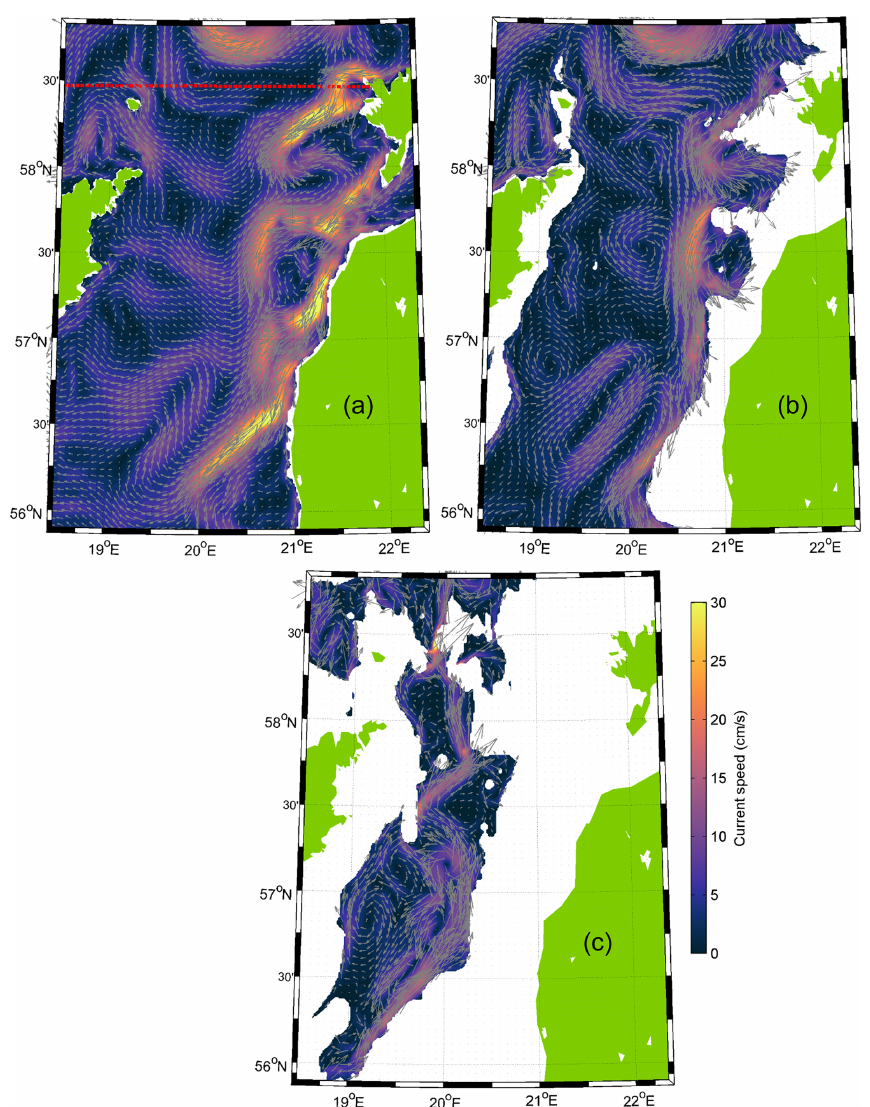
Figure 10. Mean simulated currents in the case of prevailing northerly winds from 27 May to 4 June 2020 with the thermocline at 5 (a) , 40 (b) , and 110m depth (c) . The color scale shows current speed in centimeters per second (cms − 1 ). The red dashed line in panel (a) shows the location of the transect presented in Figs. 8 and